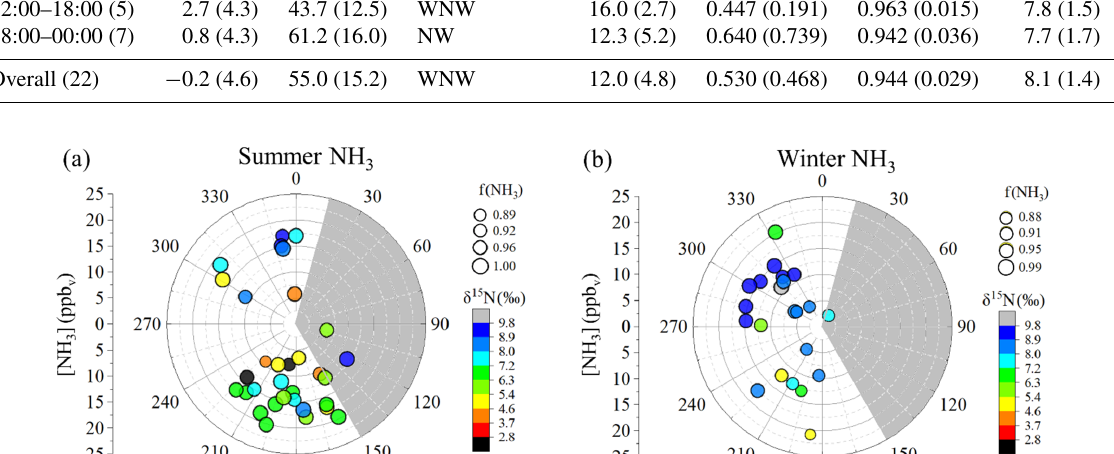
Figure 2. Wind sector analysis of samples collected at the near-highway monitoring site (Providence, RI, USA) for [ NH 3 ] (circles) in (a) summer and (b) winter. The data are coded by size for f ( NH 3 ) and color-coded for δ 15 N ( NH 3 ) (‰). The monitoring location is downwind of I-95 except for wind directions 15 to 150 ◦ (grey shaded